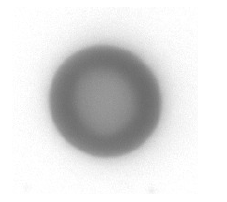
Figure 4. Typical shapes. ( a ): stomatocyte. ( b ): E1. ( c ): E2. ( d ): P1. ( e ): P2. The scale bar indicates